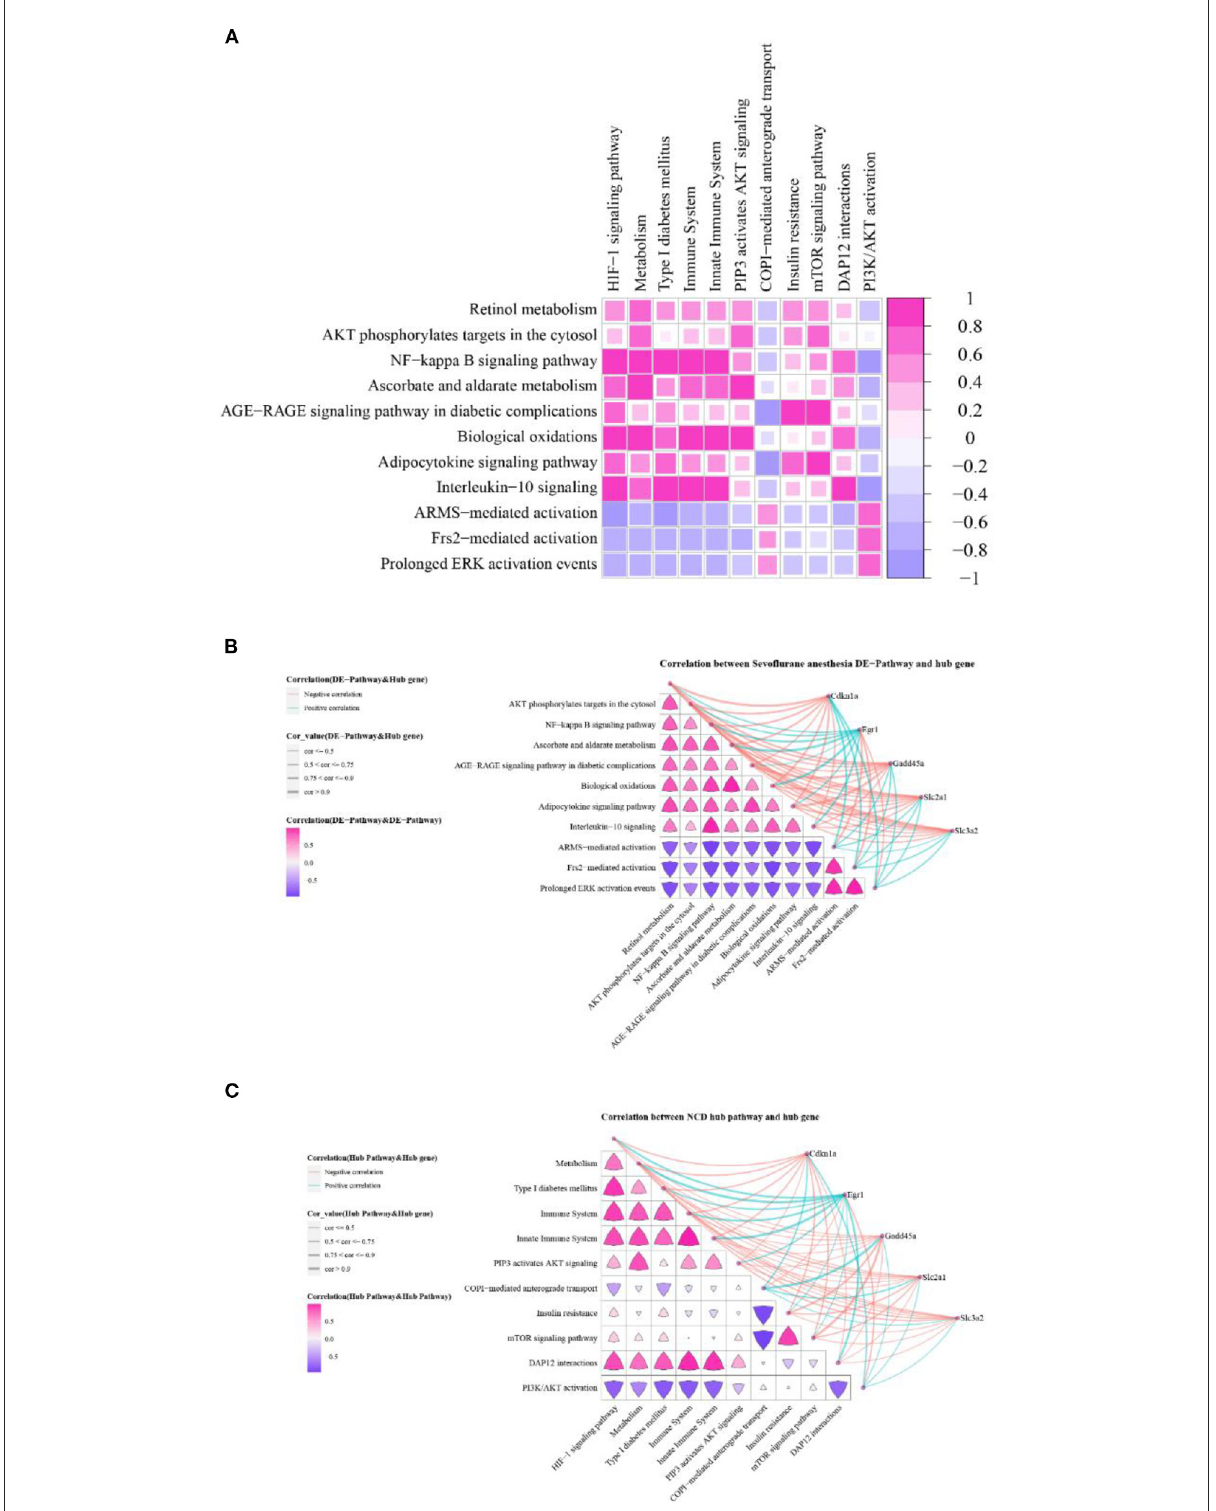
FIGURE7 Hub cross talk gene and pathway correlation. (A) Correlation of Sevoflurane anesthesia DE-pathway and NCD hub pathway. (B) Correlation between Sevoflurane anesthesia DE-pathway, and hub cross talk gene and Sevoflurane anesthesia DE-pathway. (C) The correlation between the NCD hub pathway and the hub cross talk gene and the NCD hub